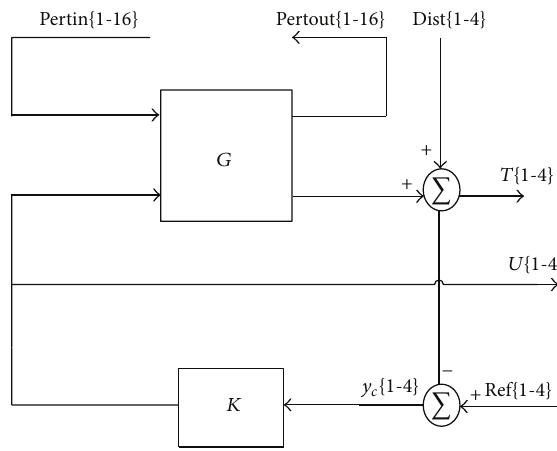
Figure 11: Structure of the closed-loop